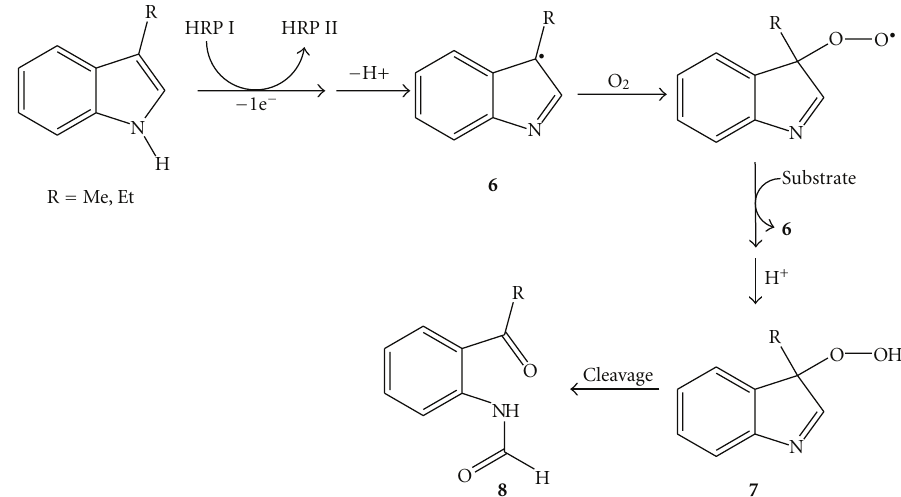
Scheme 4: Proposed mechanism for the cleavage of indoles catalysed by HRP under aerobic conditions.